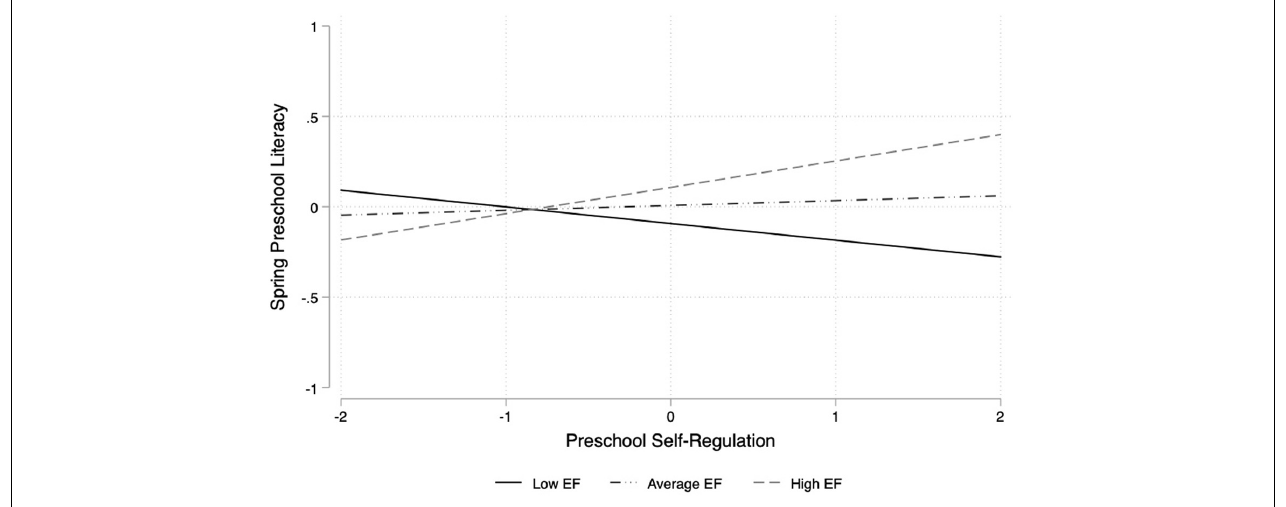
FIGURE 1 | Interaction between teacher-rated self-regulation and direct assessment of executive function for children’s spring of preschool literacy skills. Note. EF = Executive Function; Executive Function and Self-Regulation are mean-centered and standardized; Low EF = 1 SD below the mean, Average EF = mean, High EF = 1 SD above the